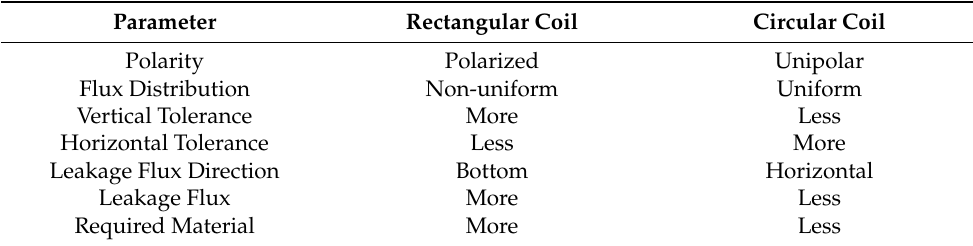
Table 4. Coil Characteristics